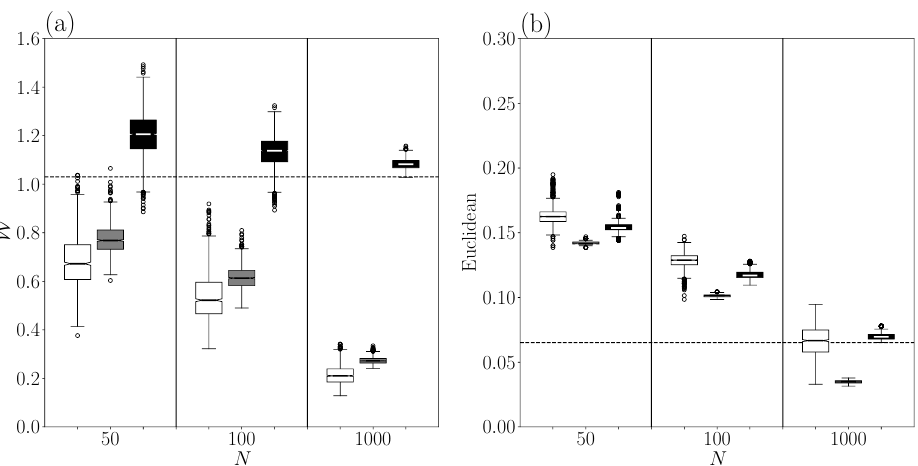
Figure 3. box plots of distances computed using the Wasserstein distance (a) and the Euclidean one (b) . White box plots differentiate between two winter snapshots. Grey box plots differentiates two summer snapshots. Black box plots compare winter and summer snapshots. Dotted lines represent the distance between winter and summer attractors with N